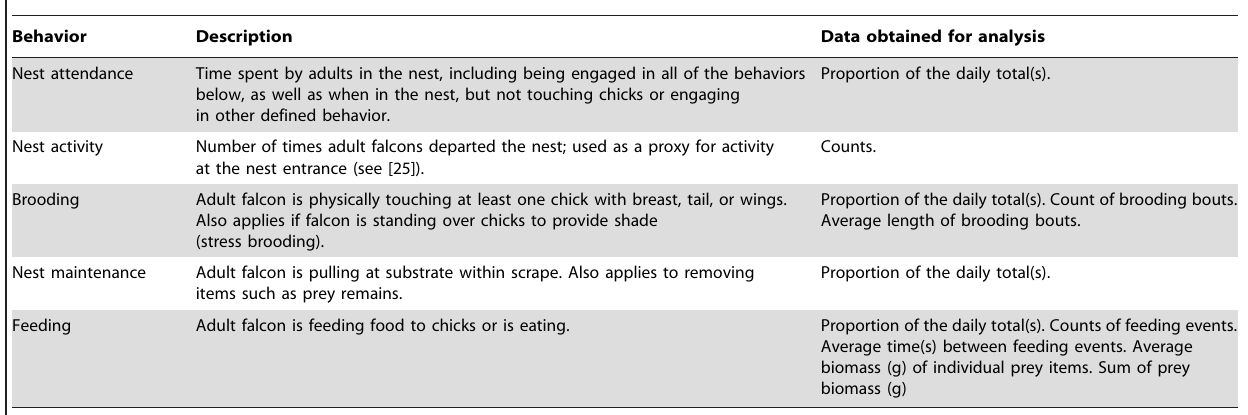
Table 1. Parental behavior recorded at each falcon